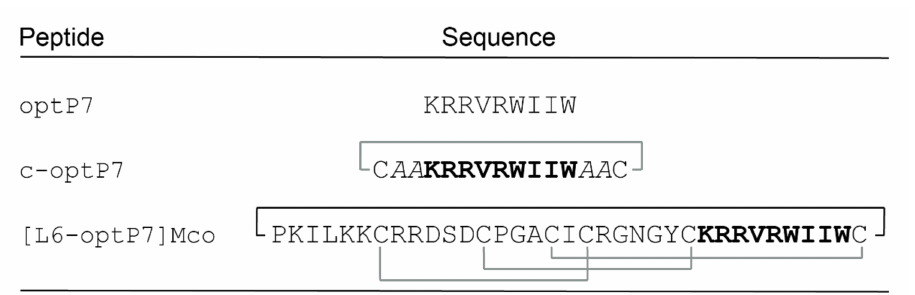
Figure 2. Peptides used in this study. The linear peptide optP7 was disulfide-cyclized (c-optP7), as well as grafted into loop 6 of the MCoTI-II scaffold ([L6-optP7] Mco). Disulfide-linkages are shown in grey, backbone cyclization of [L6-optP7]Mco is shown with a black line. Italic font denotes β -alanine